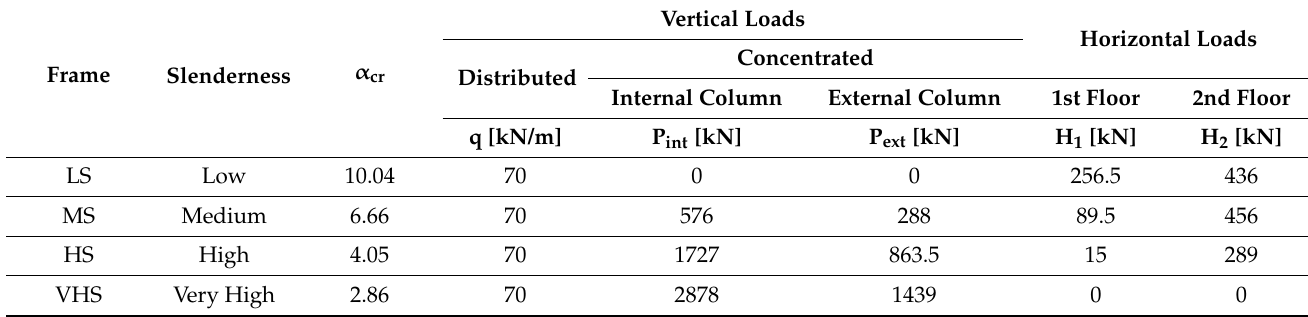
Figure 4. Derivation of loads for the examined frames (MS). Table 2. Applied loads and α cr coefficients of the examined